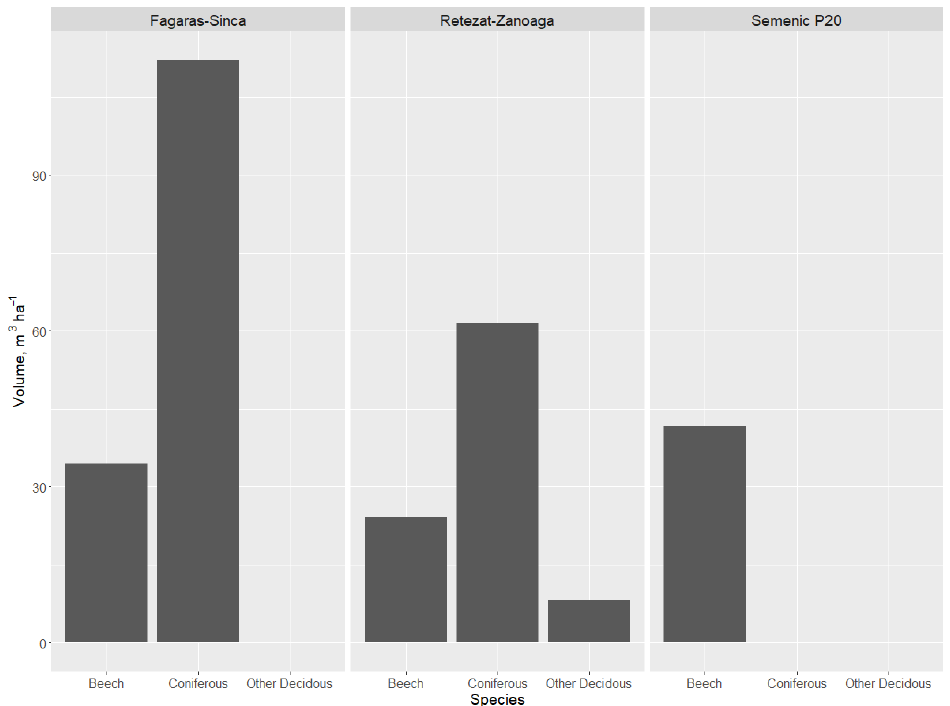
Figure 3. Dead wood volume in relation to species group. Of the total research plot volume (living and dead wood), the volume of coniferous DW varied between 16% in Retezat –Zănoaga and 25% in Făgăraș–Șinca. For beech, the DW percentage of the total research plot volume was lowest in Retezat –Zănoaga— a mixed forest — and highest in Semenic P20 — a pure beech forest (Table 4). For the other deciduous trees (sycamore and mountain elm), the volume was 8 m 3 ·ha −1 (Retezat – Zănoaga). The total DW volume ranged between 48 m 3 ·ha −1 (in Semenic P20) and 148 m 3 ·ha −1 (in Făgăraș–Șinca), with the total volume (dead and alive) ranging between 725 m 3 ·ha −1 and 964 m 3 ·ha −1 . Table 4. Volume of dead wood and living trees related to the group of species. Research Plot